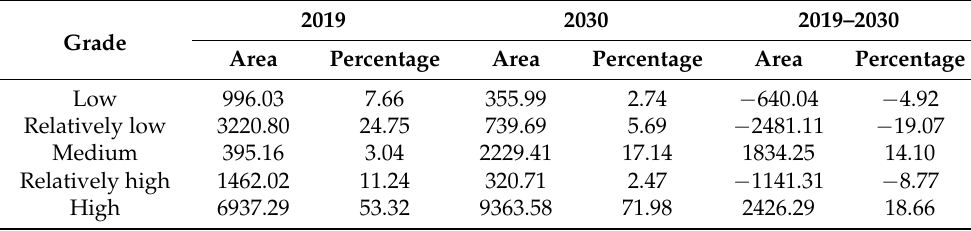
Table 10. Habitat quality forecast along the Yellow River section of the Hobq Desert in